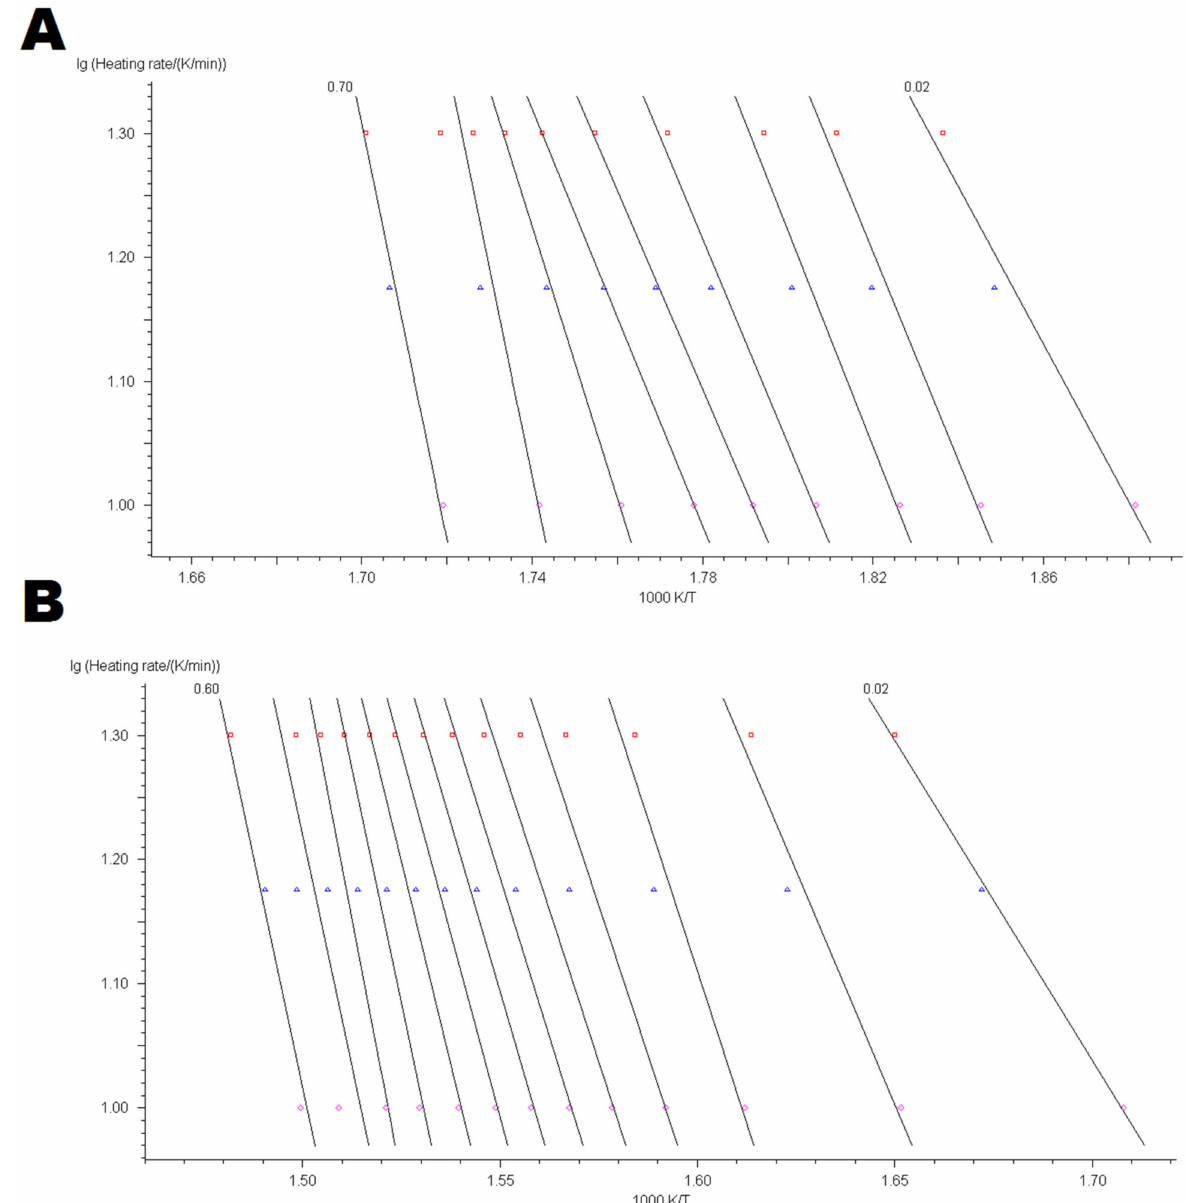
Figure A2. Ozawa-Flynn-Wall POM-P analysis plot lg (heating rate) vs. 1000 K/T: ( A ) sample investigated in an oxygen atmosphere; ( B ) sample investigated in an inert atmosphere. Lines are drawn through isoconversion points for the measurement with 10 ( ♦ ), 15 ( ∆ ), and 20 ( (cid:3) ) ◦ C/min heating